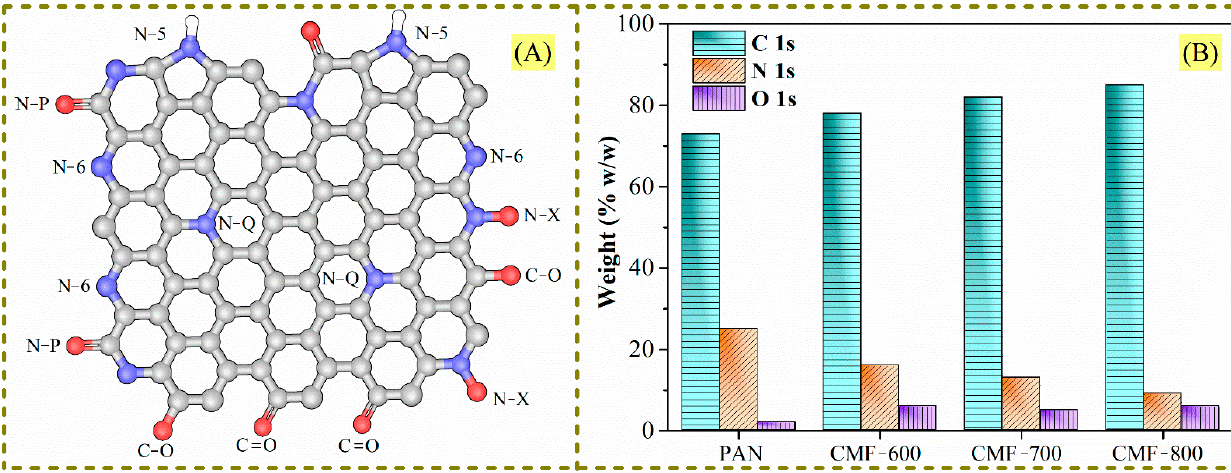
Figure 1. ( A ) Functional groups and ( B ) chemical composition (XPS results) in carbon microfibers.